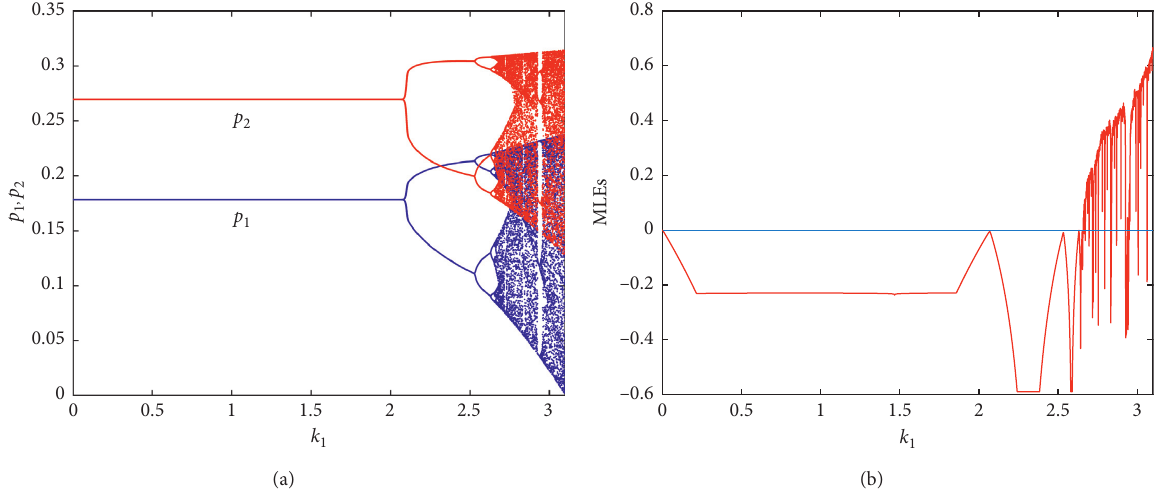
Figure 2: Bifurcation diagram and MLEs for system (12) with respect to parameter k